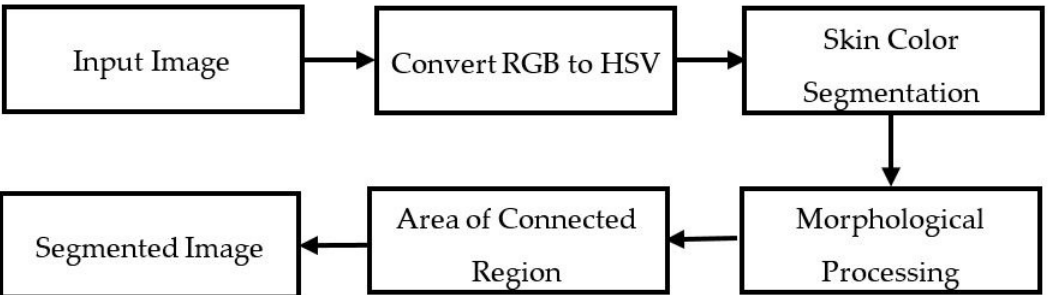
Figure 4. Block diagram of the SkinMask segmented process.